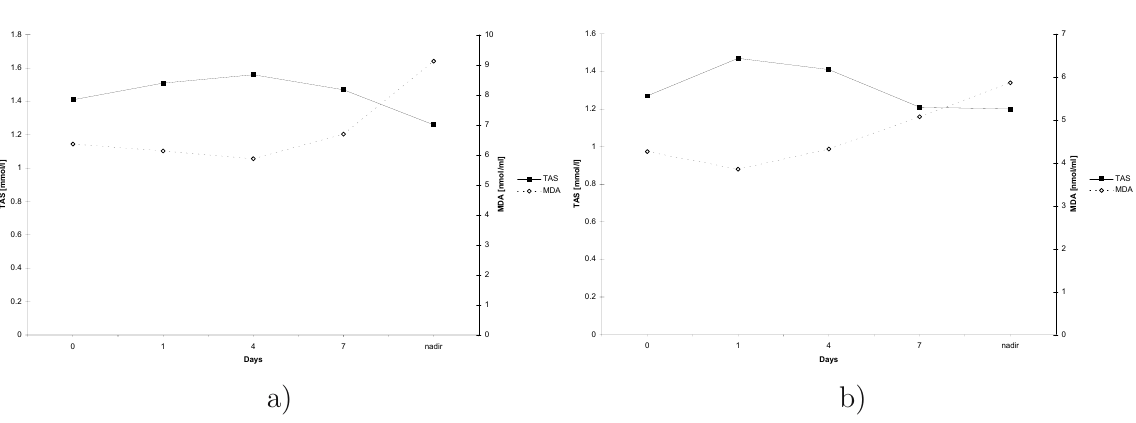
Fig. 3 Comparison between the changes in TAS and MDA average values in AML pa- tients during chemotherapy